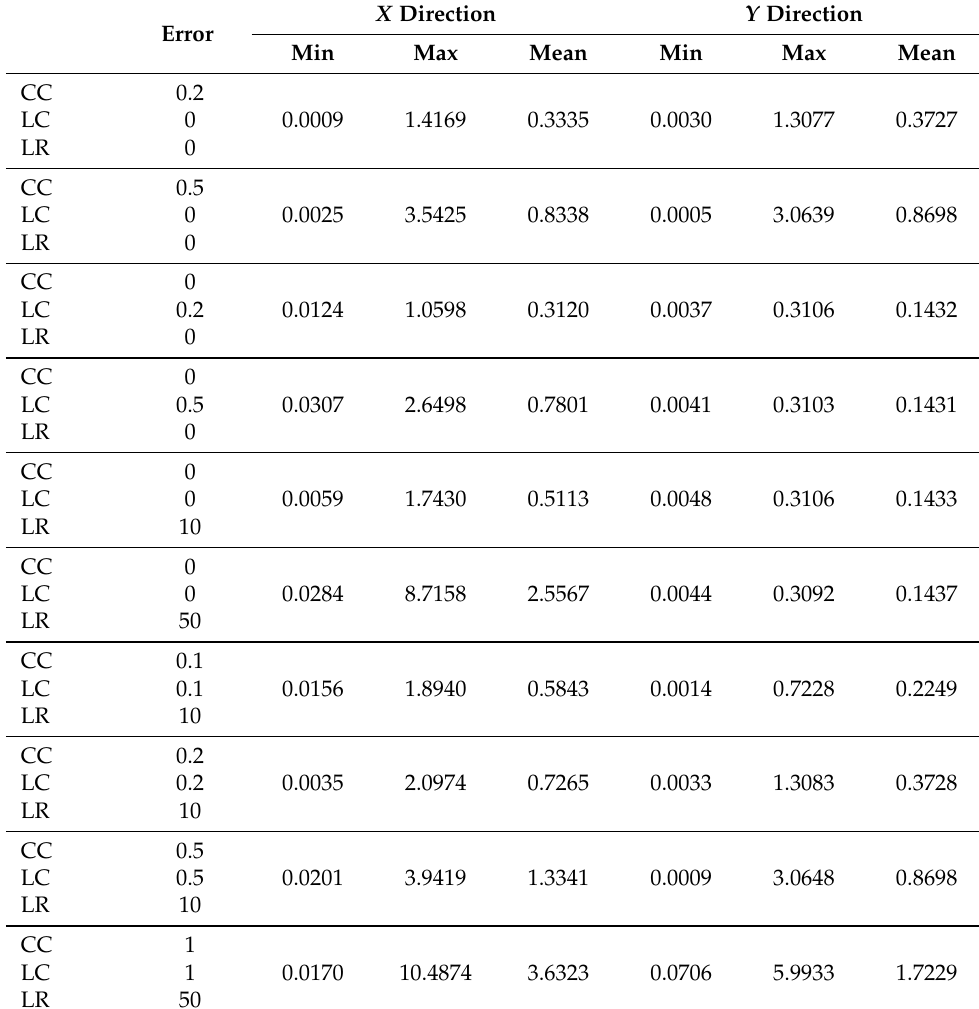
Table 1. Observation error and calibration solution